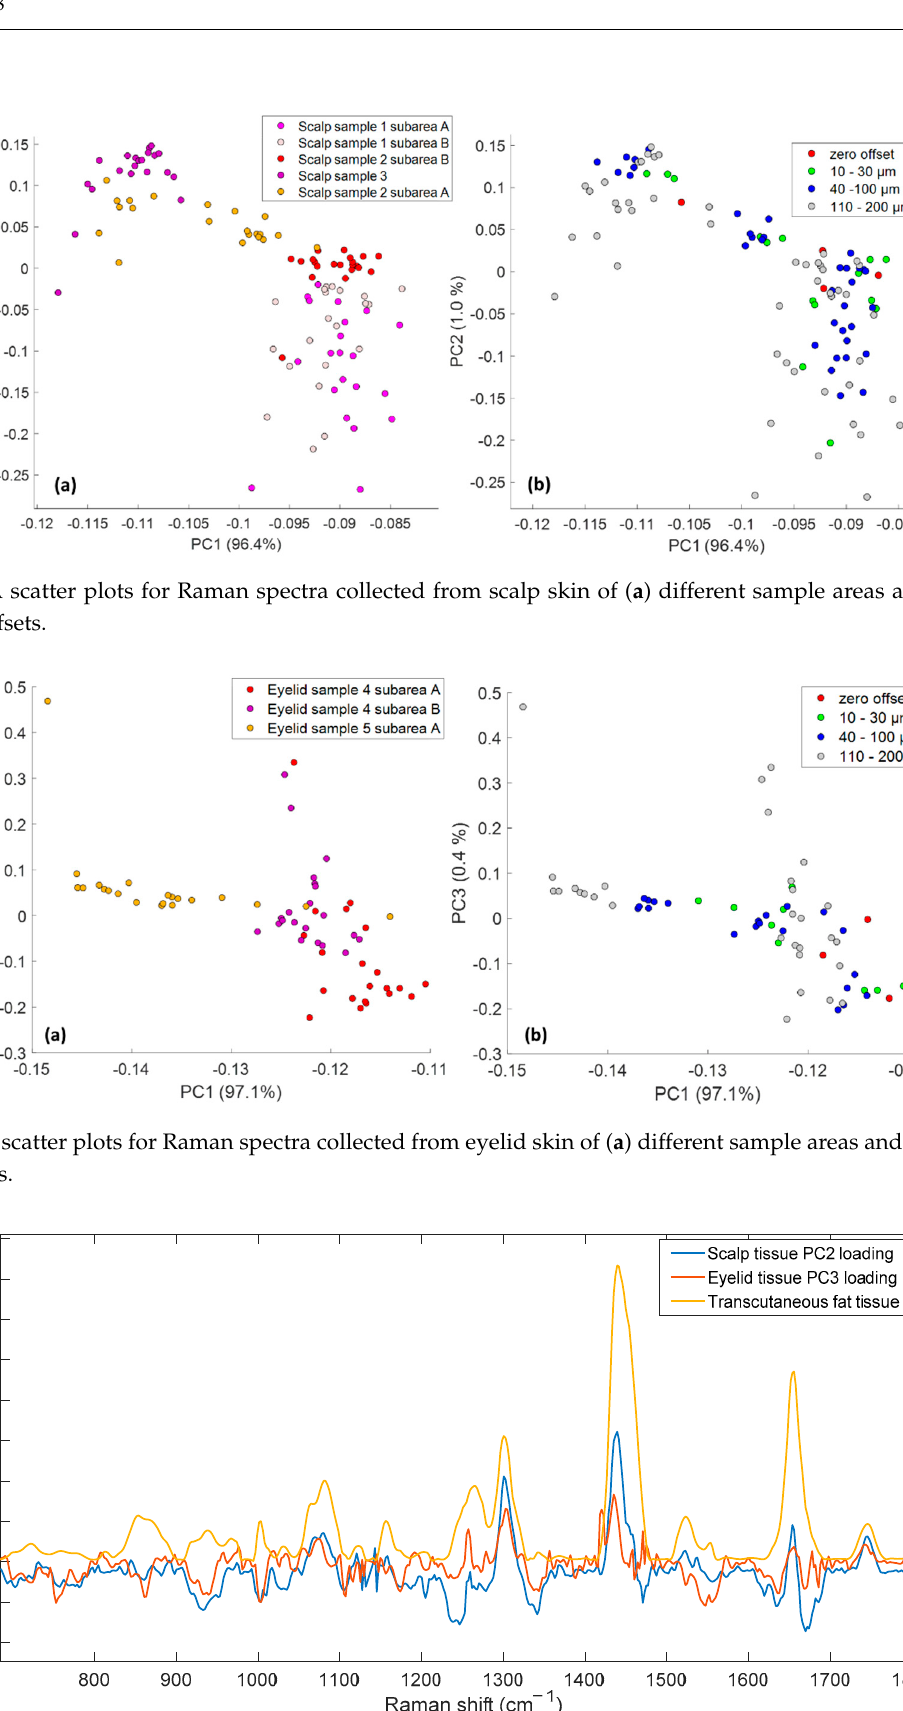
Figure 8. PC3 loading (0.4%) of eyelid SORS dataset and PC2 loading (1%) of scalp tissue SORS dataset subplotted with the reference Raman spectrum of the subcutaneous fat layer.